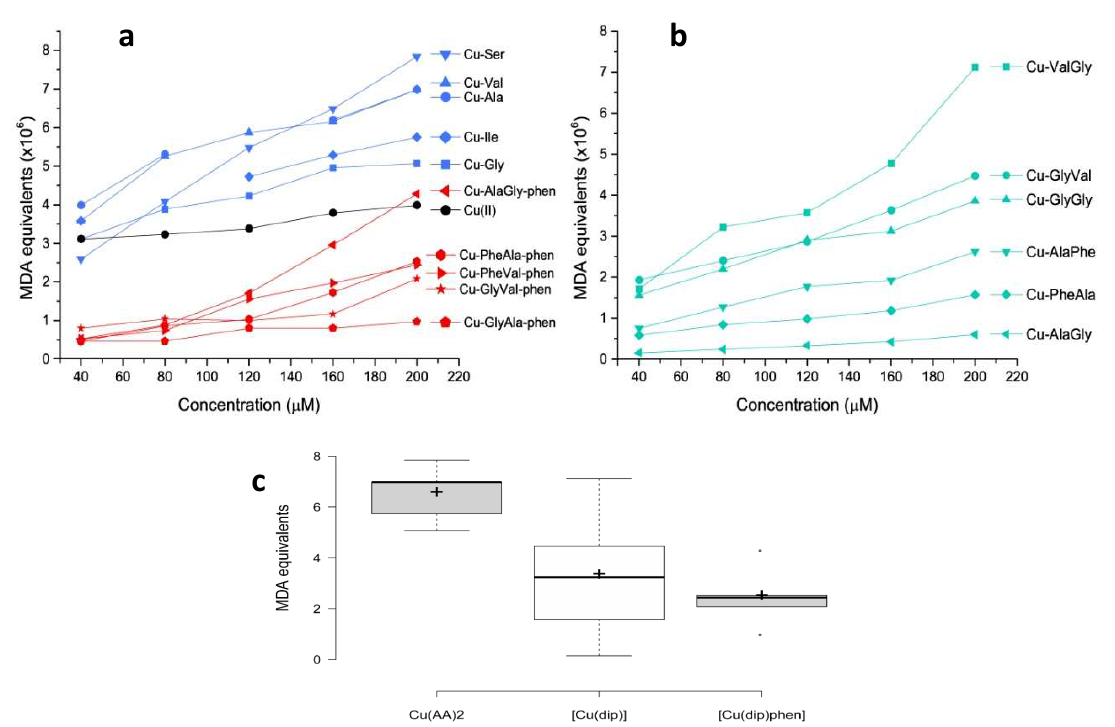
Figure 4. Oxidative damage to 2-deoxy- D -ribose induced by Cu(II) complexes expressed as MDA equivalents for: ( a ) copper complexes with amino acids and with dipeptide–phenantroline and ( b ) copper complexes with dipeptide. In ( c ), comparative boxplots of the MDA equivalents ( × 10 6 ) at 200 µ M are shown for each group of complexes.